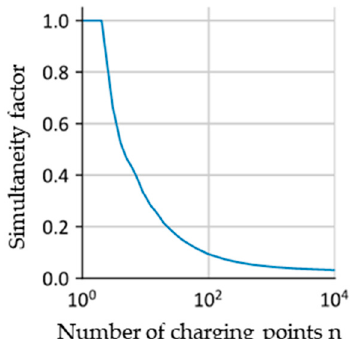
Figure 4. Simultaneity curve for 11-kW charging points according to [45].